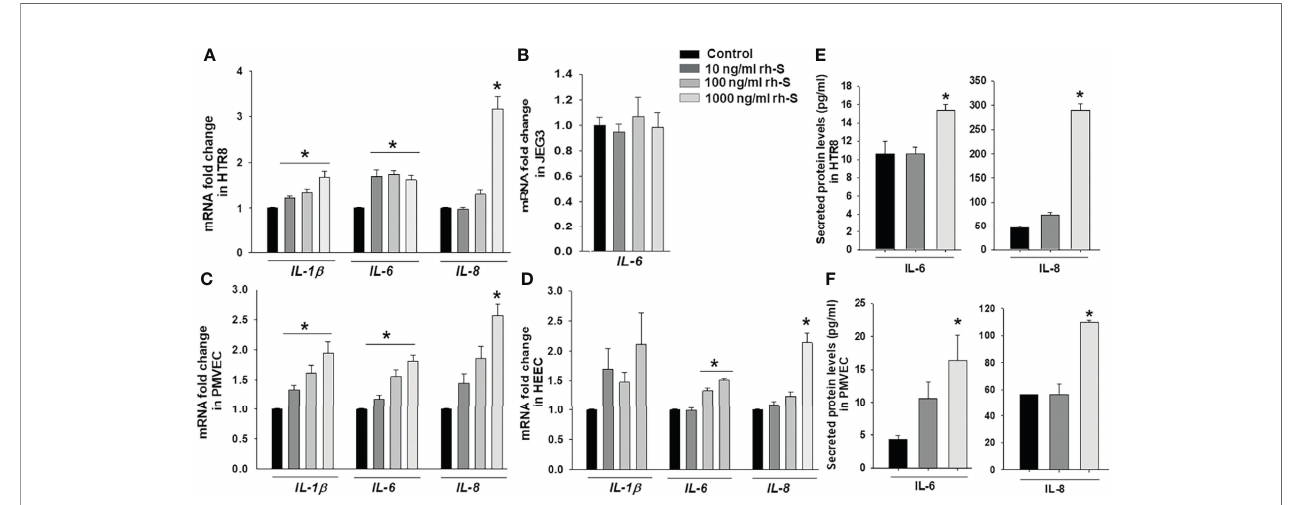
FIGURE 2 | Induction of pro-in fl ammatory cytokine in trophoblast and endothelial cell cultures by rh-S-protein. SARS-CoV-2 induced expression of pro-in fl ammatory cytokines IL-1 b , IL-6 and IL-8 mRNA levels in trophoblastic cells HTR8/SV Neo (A) and JEG3 (B) as well as PMVEC (C) and HEEC cultures (D) treated with 10, 100, or 1000 ng/ml rh-S-protein vs . mock-treated control treatment. Bars represent mean ± SEM, n=4; * P<0.05 vs. control; and IL-8 mRNA * P<0.05 vs. control or 10 or 1000 ng/ml rh-S protein (A, C, D) . Secreted IL-6 and IL-8 protein levels in culture supernatants of HTR8 (E) and PMVECs (F) treated with control or 10 or 1000 ng/ml rh-S-protein. Bars represent mean ± SEM, n=3; * P<0.05 vs. control (E, F)